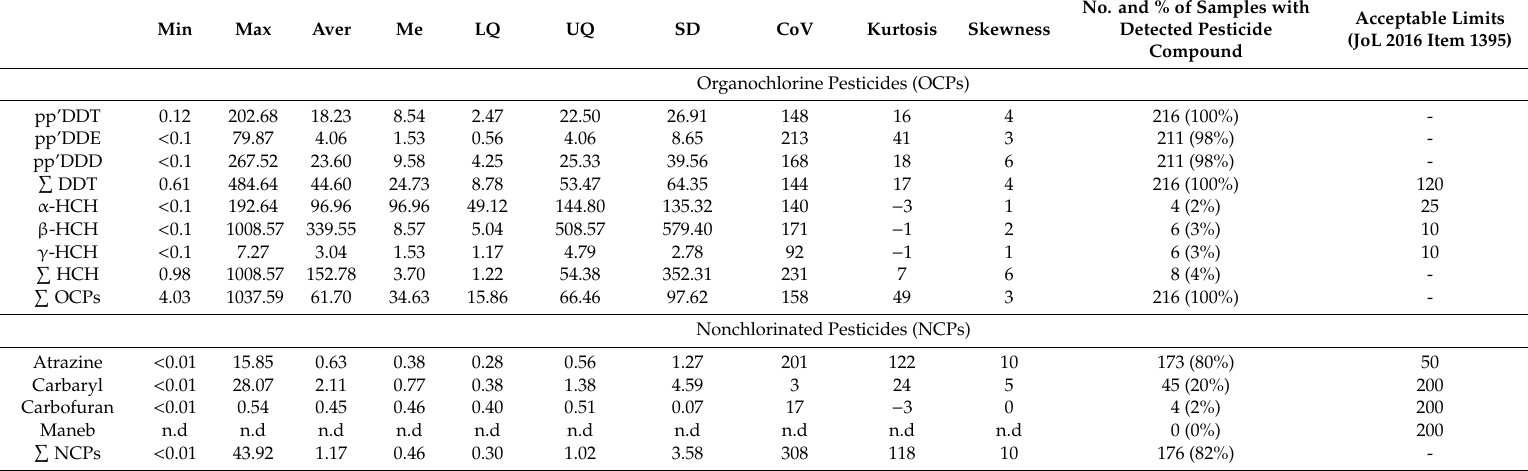
Table 2. Results of OCPs and NCPs concentrations in Polish agricultural soils ( n =